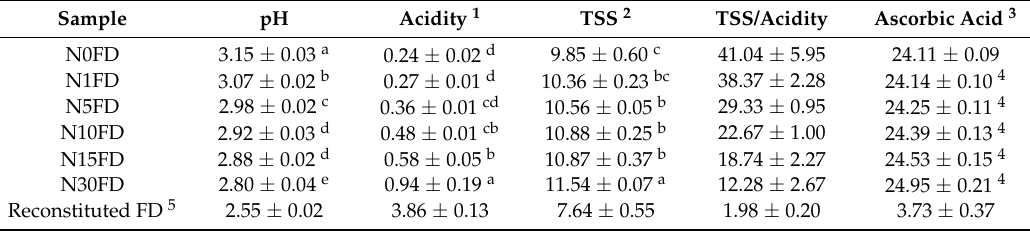
Table 4. Physicochemical parameters * of non-supplemented apple nectar (N0FD), apple